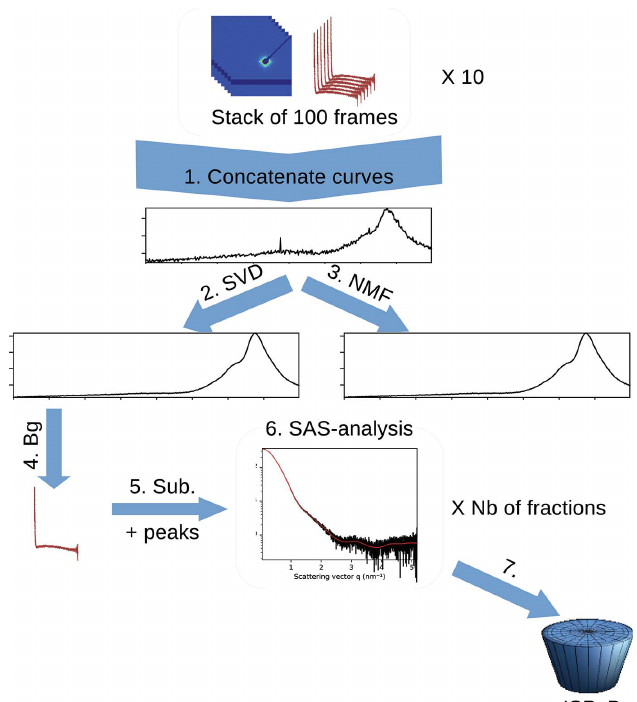
Figure 8 Schematic of the HPLC pipline: 1, concatenate; 2–3, multivariate analysis; 4, background extraction; 5, peak finding; 6, SAS analysis on each fraction; 7, storage to ISPyB.